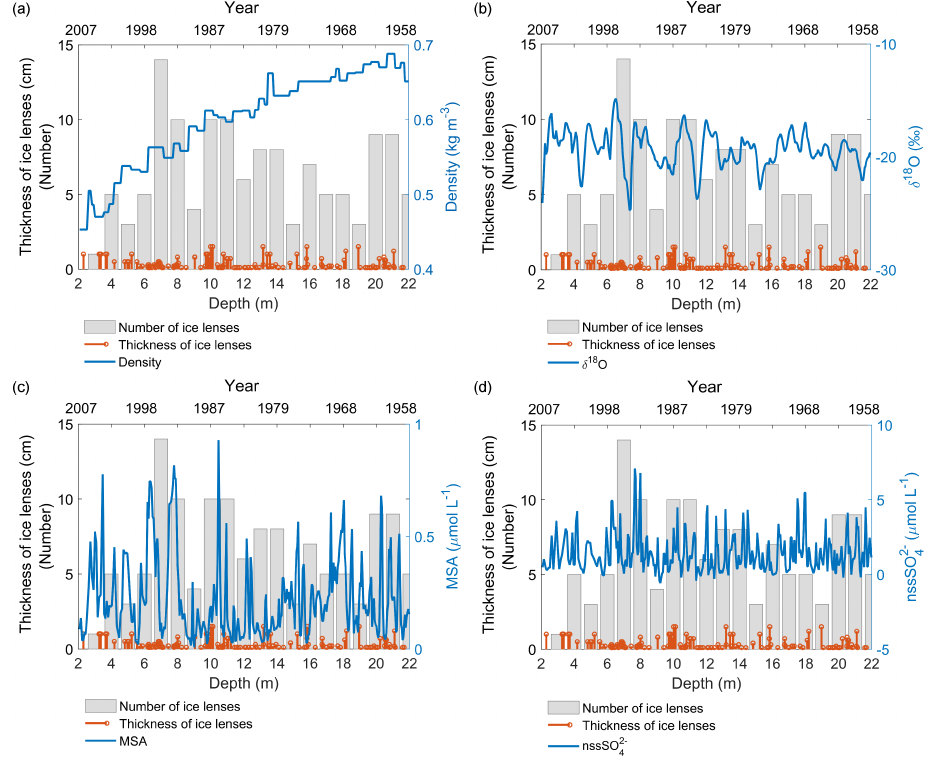
Figure 6. (a) Number of ice lenses per metre (bars), ice lens thickness (stems), and density profiles (line) available at KC. Panels (b, c, d) are the same as (a) but with the δ 18 O, MSA, and nssSO 2 − profiles (lines) instead of density. 4